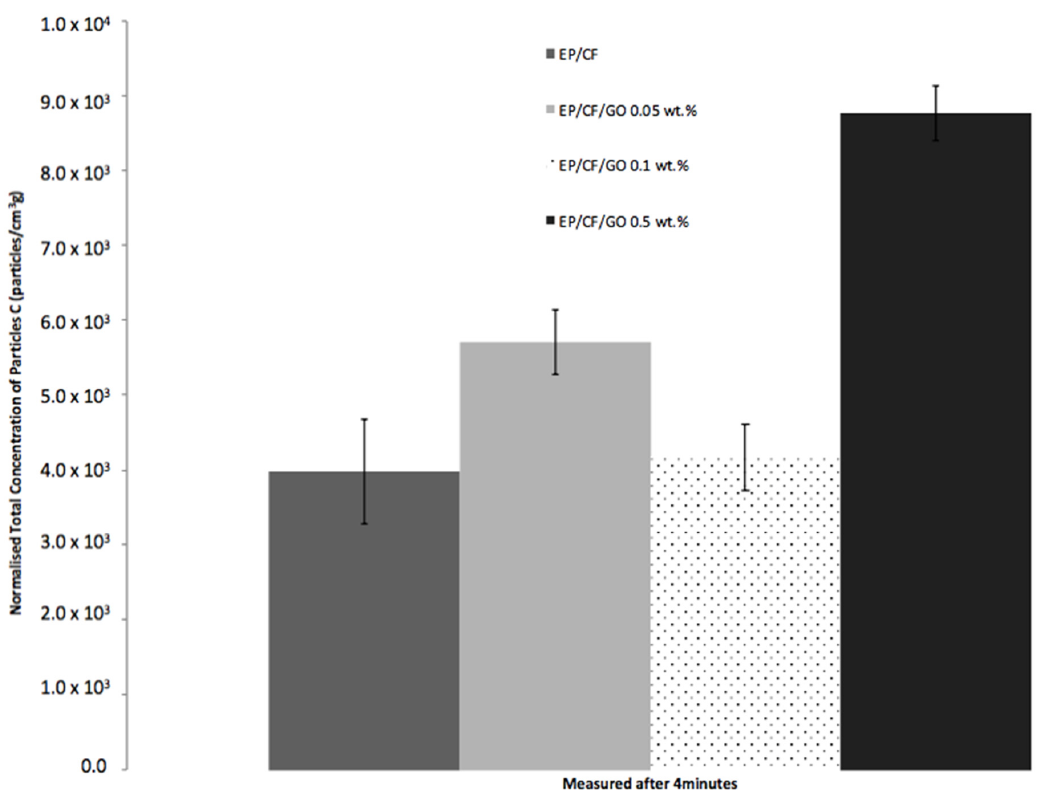
Figure 9. Normalized total concentration of particles (C divided by estimated drilled mass) recorded at 4th min for EP/CF based samples reinforced with GO (n = 3 for each average).